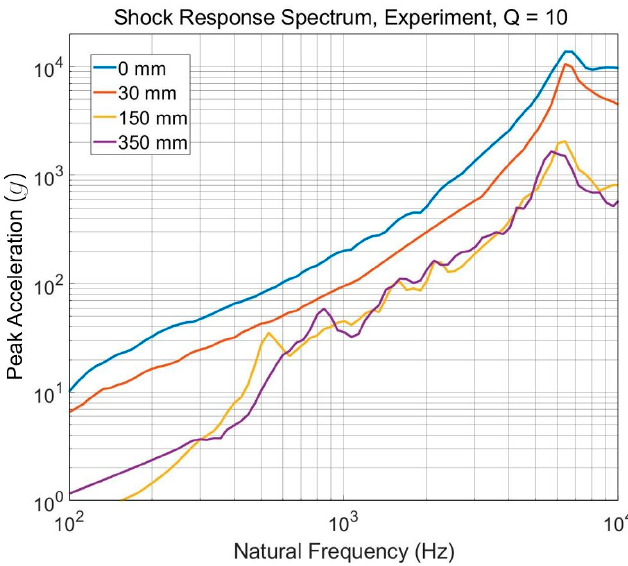
Figure 18. SRS of shock ‐ propagation test using pyroshock simulator.